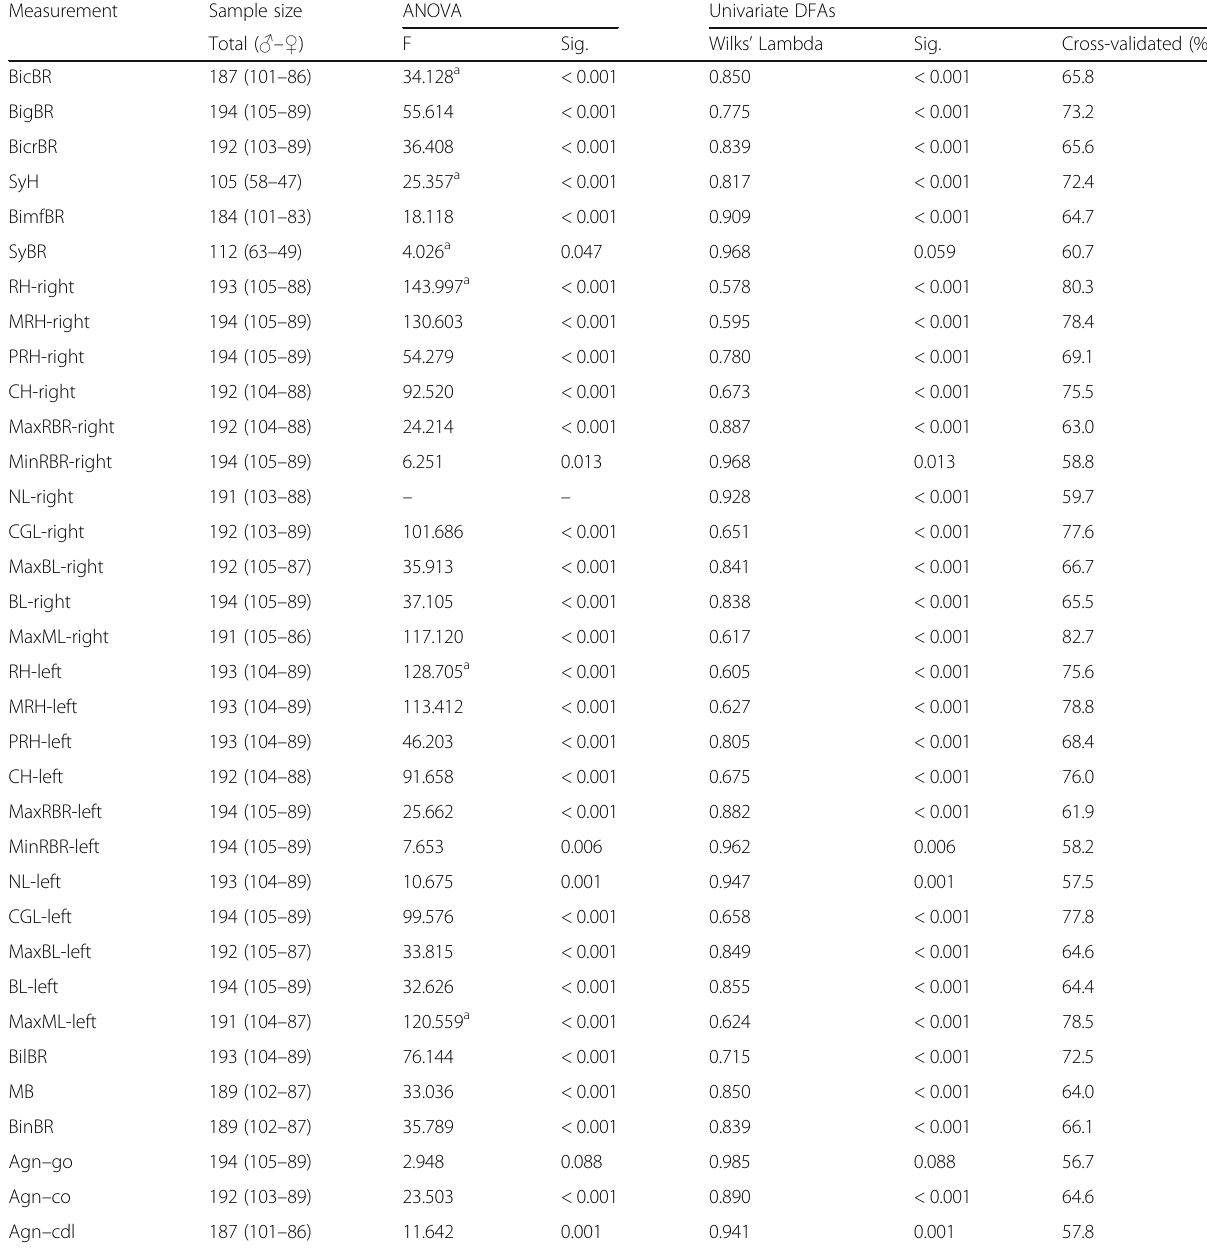
Table 4 ANOVA and linear discriminant analysis for each measurement variable Measurement Sample size